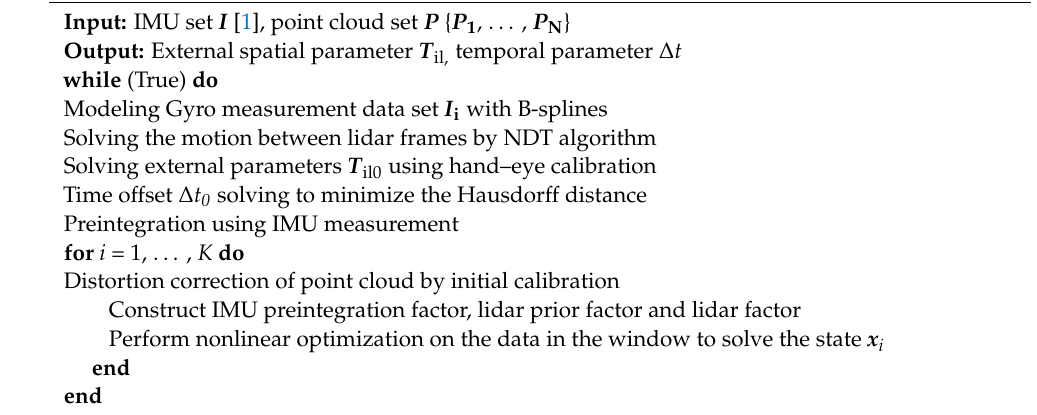
Algorithm 1: LiDAR/IMU spatiotemporal